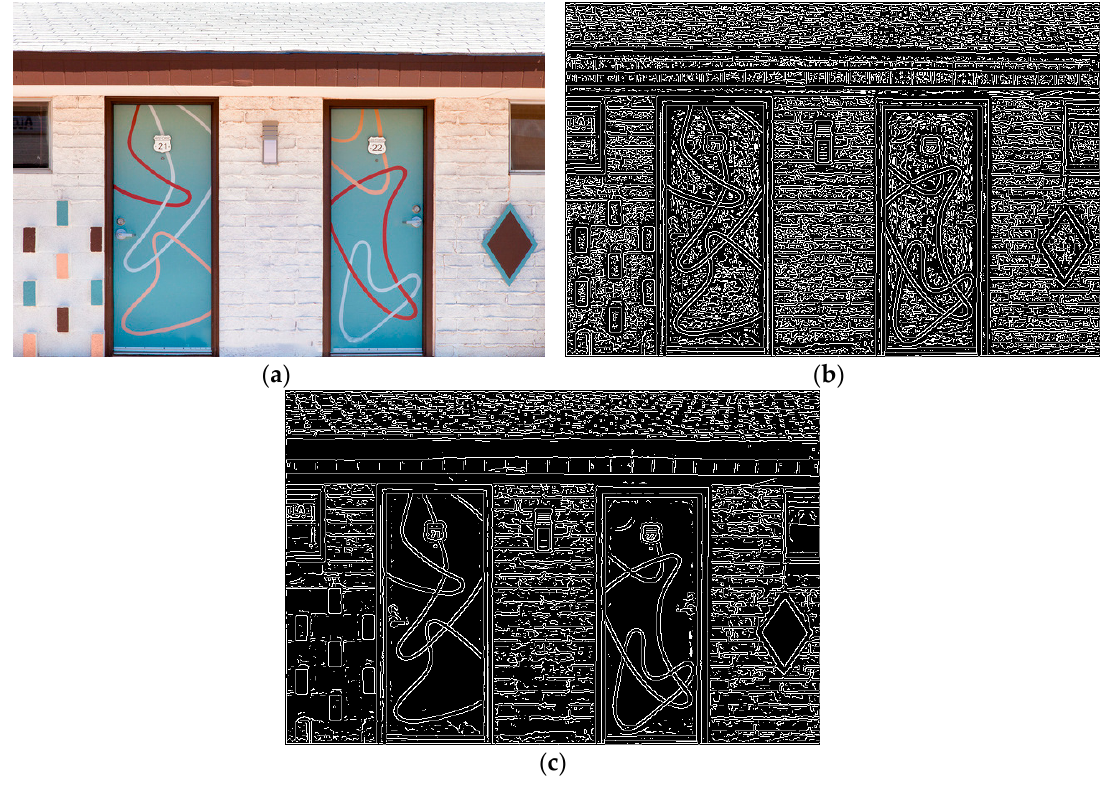
Figure 1. Noise filtering process. ( a ) Original image (640 × 427) [17]; ( b ) gradient change image before noise filtering; ( c ) gradient change image after noise filtering.